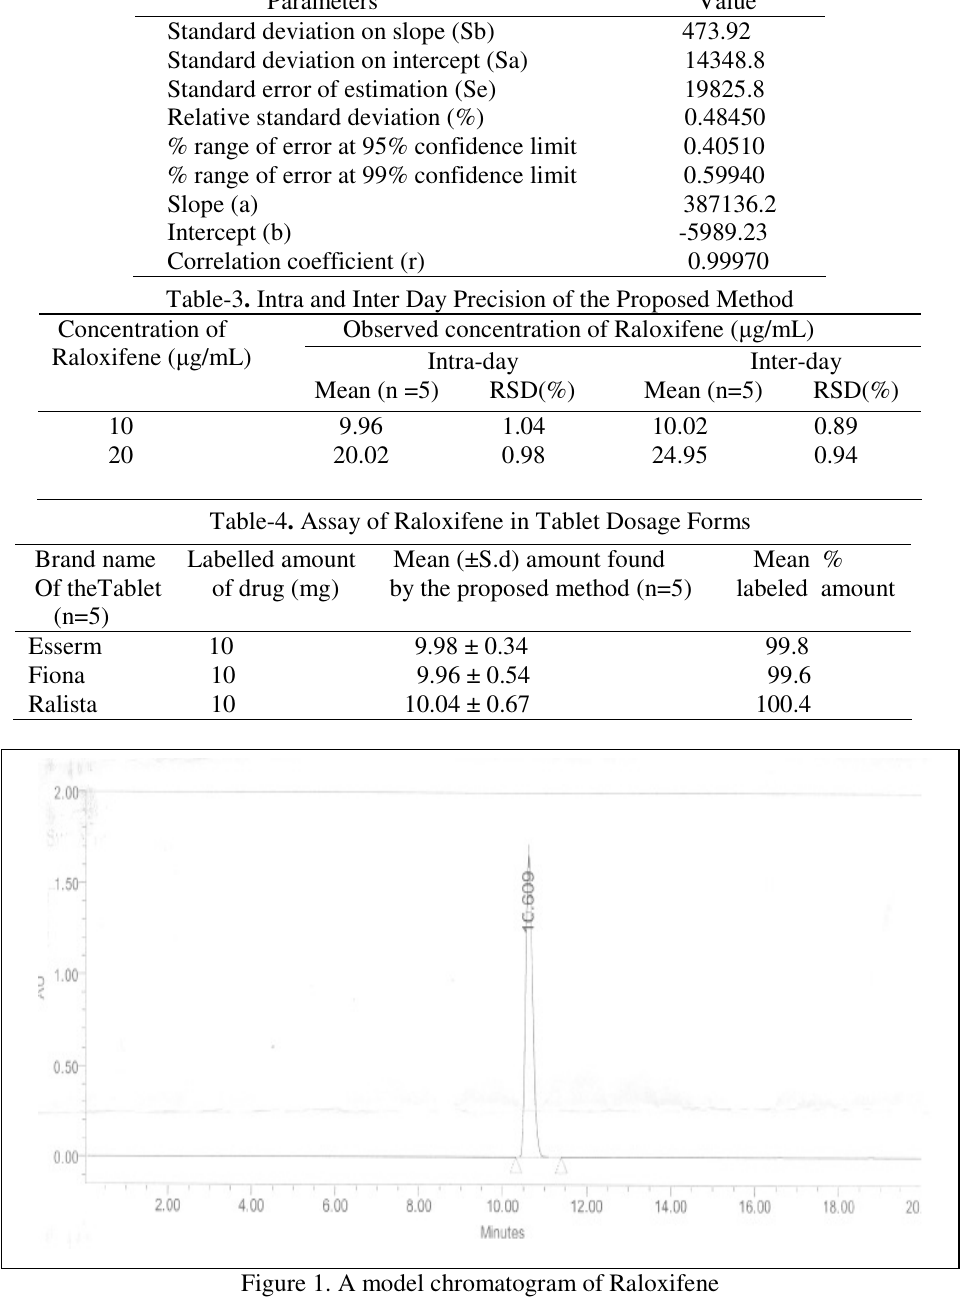
Figure 1. A model chromatogram of